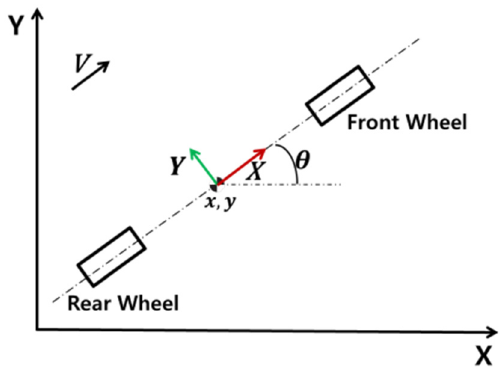
Figure 1. Vehicle state in two-dimensional Cartesian space.